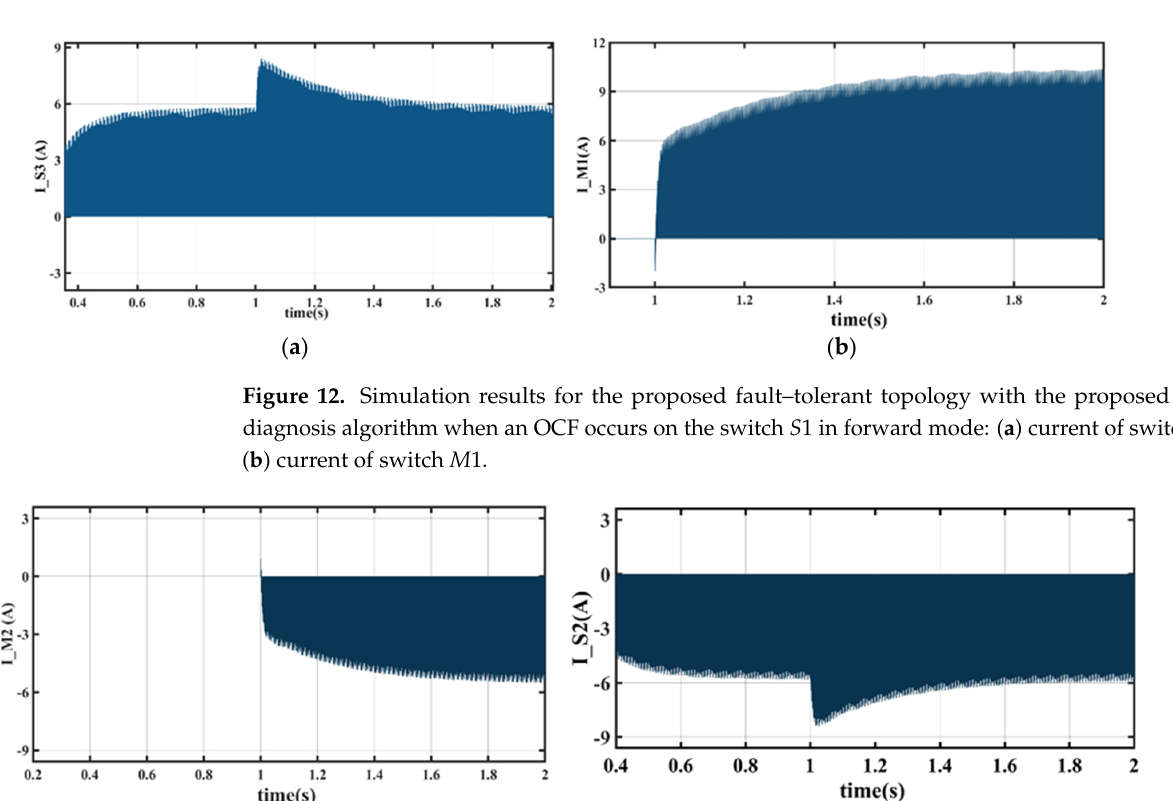
Figure 11. Simulation results during an OCF on power switch S4 in reverse mode: ( a ) current of switch S2 during an OCF on power switch S4 ; ( b ) current of switch S4 during an OCF.